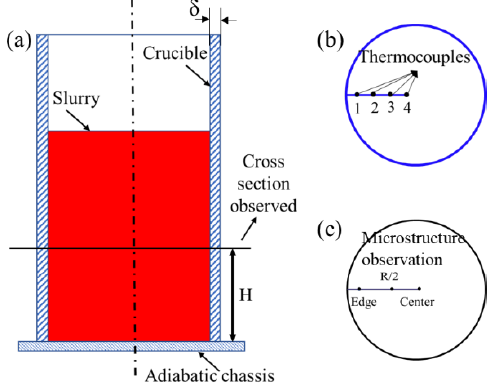
Figure 3. ( a ) Schematic of the crucible used in this study and the cross-sections for the crucible, H is the height of the observation plane, δ is the wall thickness of crucible, ( b ) temperature measuring points with thermocouples, ( c ) microstructure observation locations, named as Center, R/2 and Edge, respectively. Table 2. The detail information about the crucible and process conditions.